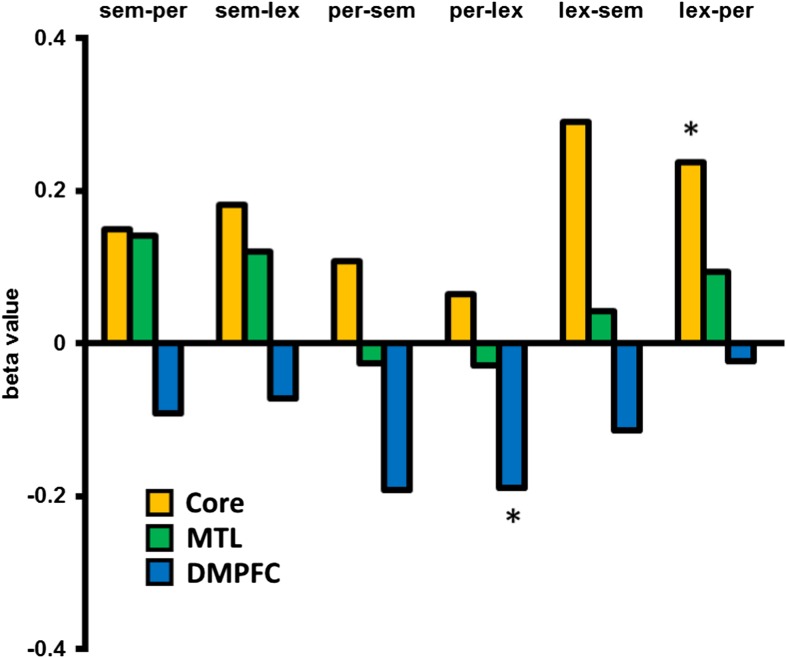
Activation associated with each between category switch.An exploratory analysis looking at the activation/deactivation associated with switching between each of the three task categories. Core and MTL sub-networks predominantly show increased activation following a dissimilar task switch across switch types, whereas DMPFC shows a relative decrease in activation. Abbreviations: sem = semantic category, per = perceptual, lex = lexical. * denotes p < 0.05 from a paired, two-tailed t-test.